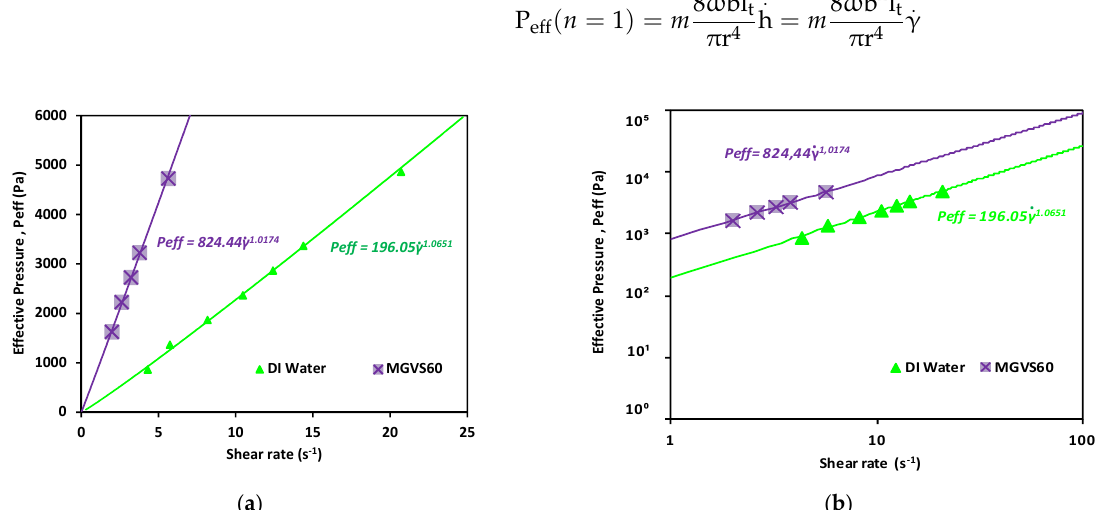
Figure 6. Effective pressure vs. shear rate obtained for the Newtonian calibration fluids studied. Newtonian fluids: DI water and MGVS60: ( a ) linear scale and ( b ) log-log scale.